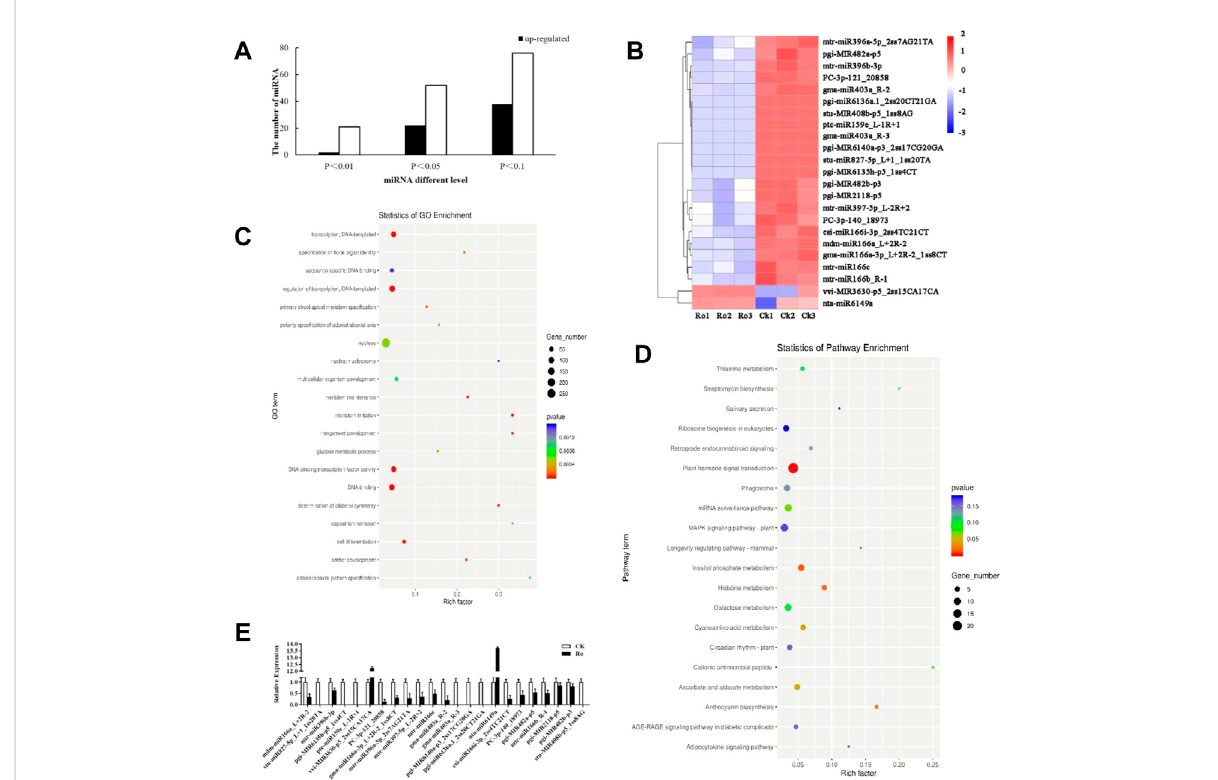
FIGURE 3 ResultsandvalidationofthedifferentialmiRNAanalysis.NumberofthedifferentiallyexpressedmiRNAsof P.ginseng hairyroots (A) .Heatmapof thedifferentiallyexpressedmiRNAsof P.ginseng hairyroots (B) .GOfunctionalenrichmentanalysisofmiRNAtargetgenesinginsengunderRostress (C) .KEGGfunctionalenrichmentanalysisofmiRNAtargetgenesinginsengunderRostress (D) .Veri fi cationofthe fl uorescenceandquantitativePCR results of miRNA (E)